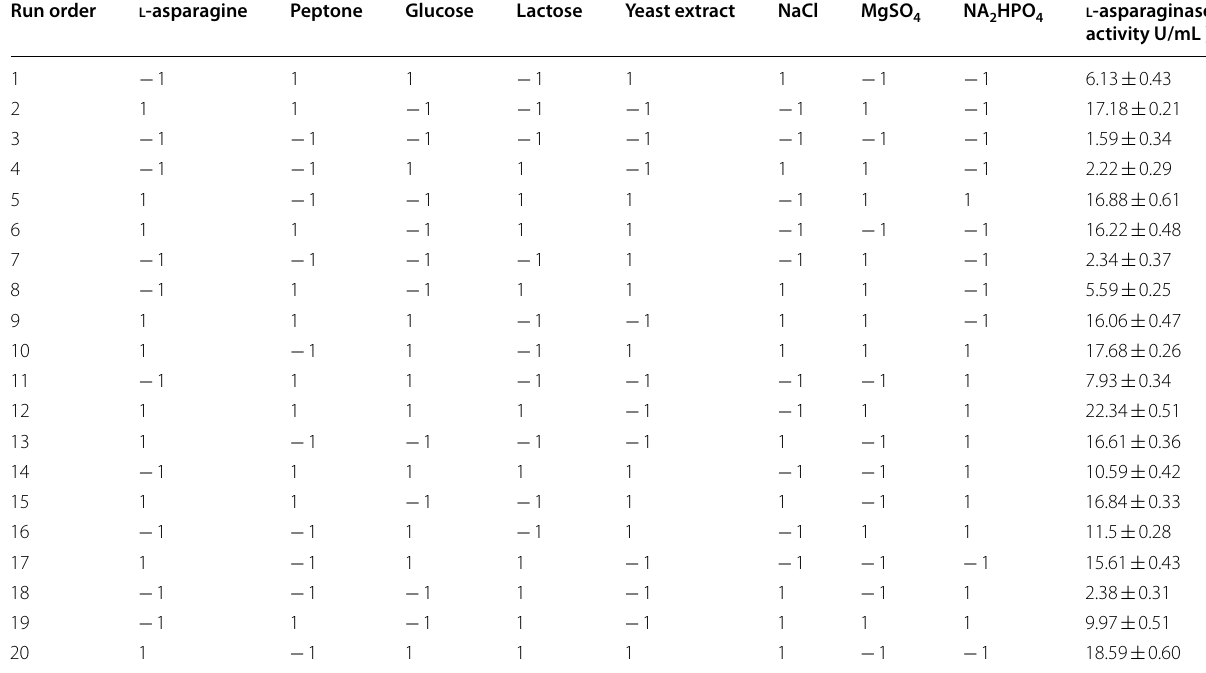
Table 2 Experimental design and results of PBD Run order